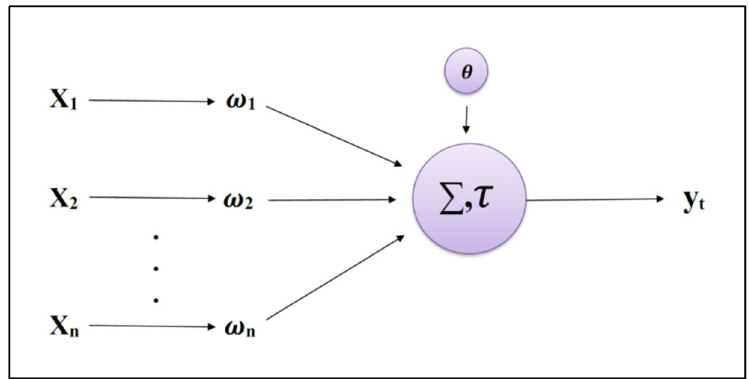
Figure 2. Illustration of the perceptron.